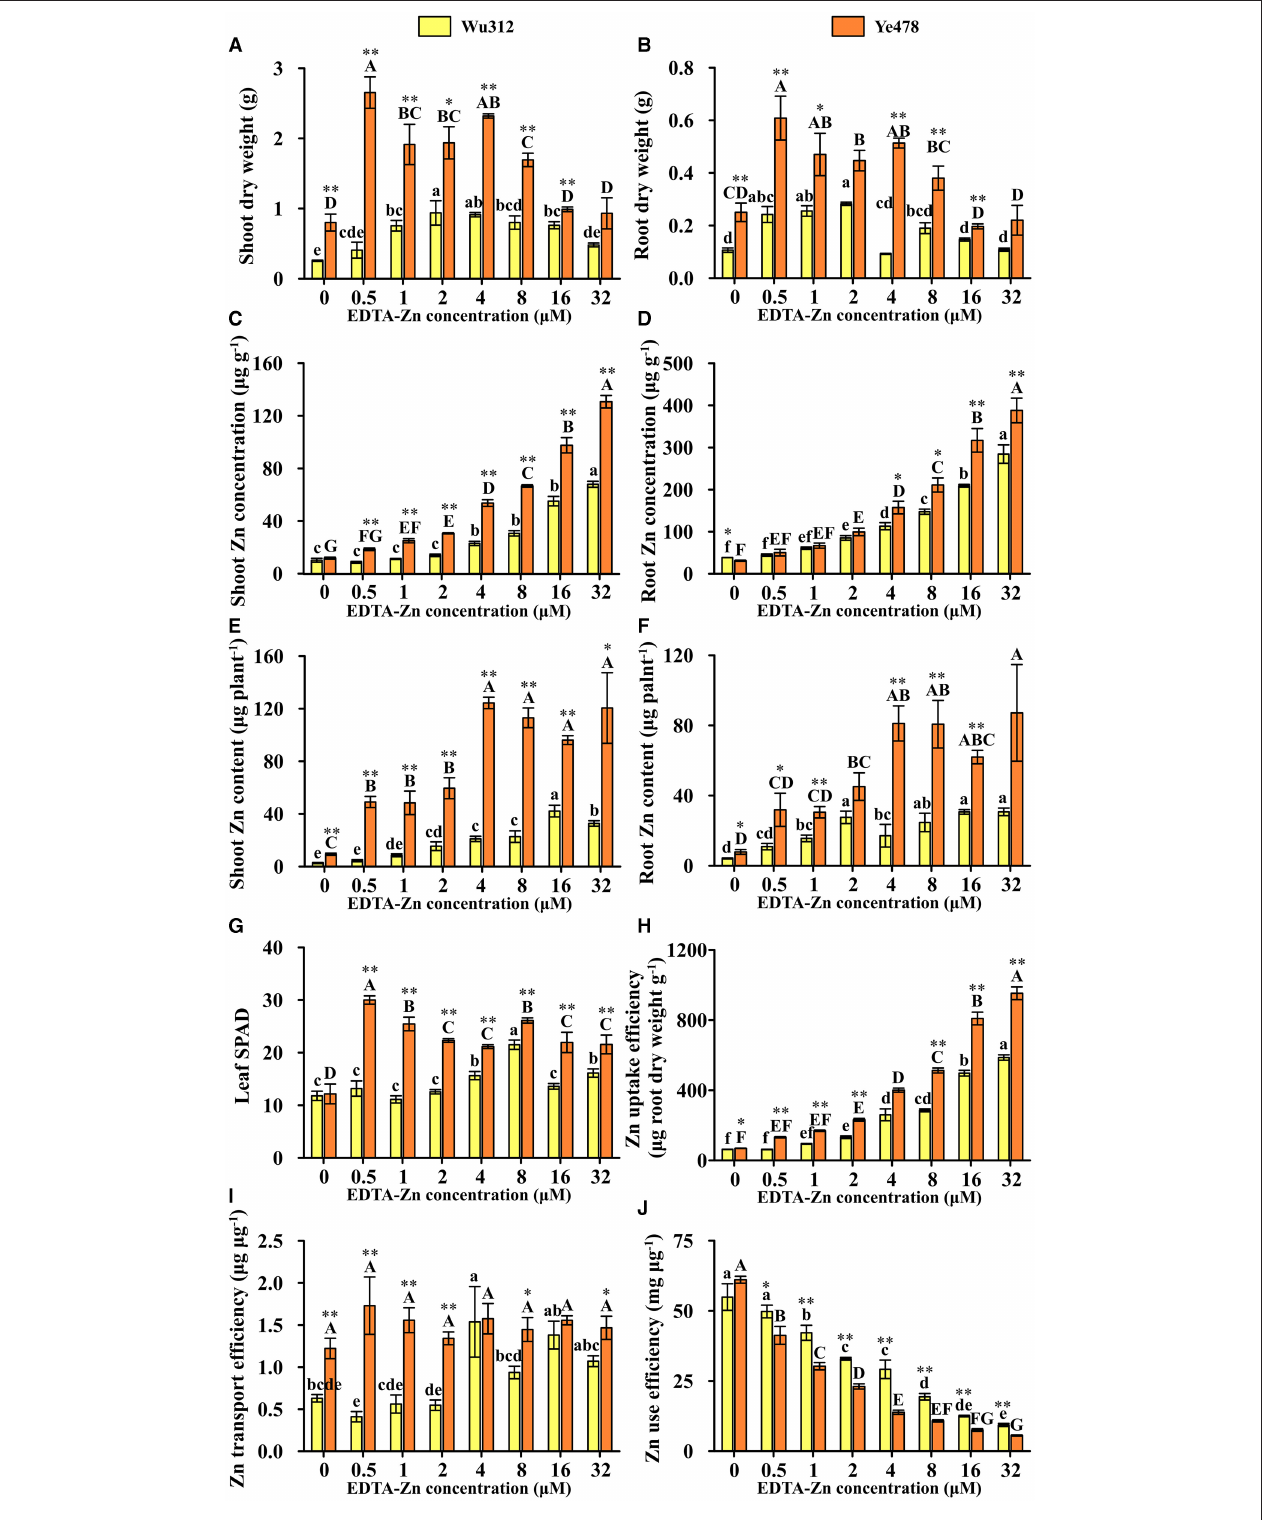
FIGURE 4 | Shoot (A) and root (B) dry weight, shoot (C) , and root (D) Zn concentration, shoot (E) , and root (F) Zn content, leaf SPAD (G) , Zn uptake efficiency (H) , Zn transport efficiency (I) , and Zn use efficiency (J) of Zn-sensitive inbred line Wu312 and Zn-tolerant inbred line Ye478 in Experiment 1. Different lowercase and upper letters indicate significant difference ( p < 0.05) of Wu312 and Ye478 among treatments, respectively. * and ** indicate significant difference between Wu312 and Ye478 at p < 0.05 and p < 0.01, respectively.